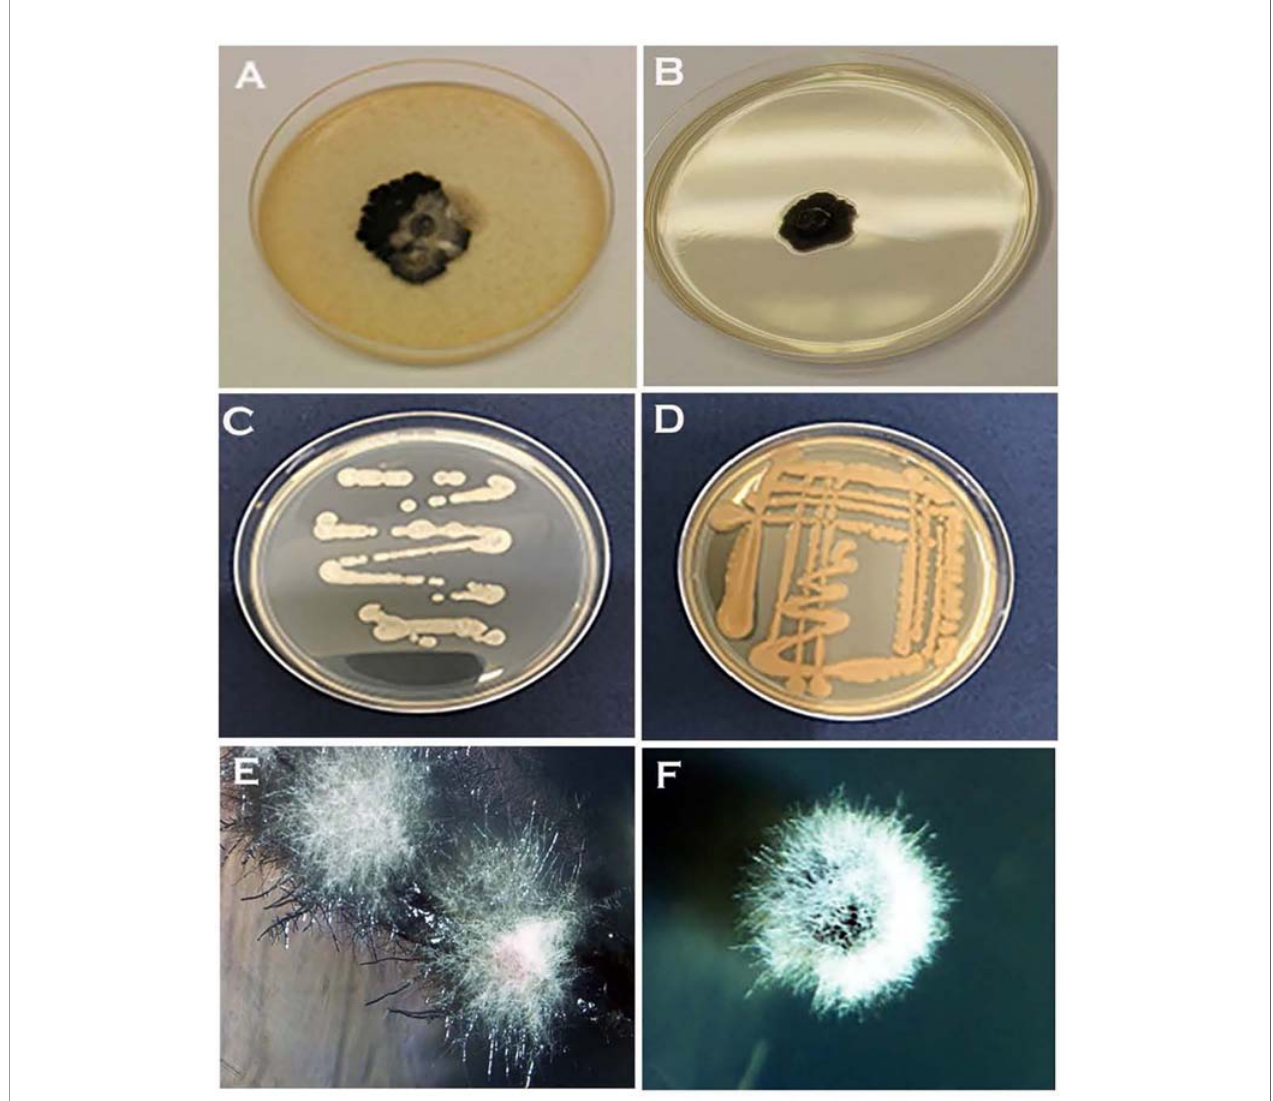
FIGURE 4 | Different colony morphologies of Neopseudocercosporella capsellae isolate UWA Wlj-3 grown on three different growth media, and with two different subculturing methods using a hyphal colony on a single growth medium. (A) Seven week old colonies on V8 juice agar and (B) PDA, inoculated with an agar plug. Four-day-old streak plate on (C) PDA and (D) V8 juice agar. (E) Four-week-old hyphal colonies on WA streak plate. (F) Three-week-old hyphal colony on NDY inoculated with an agar